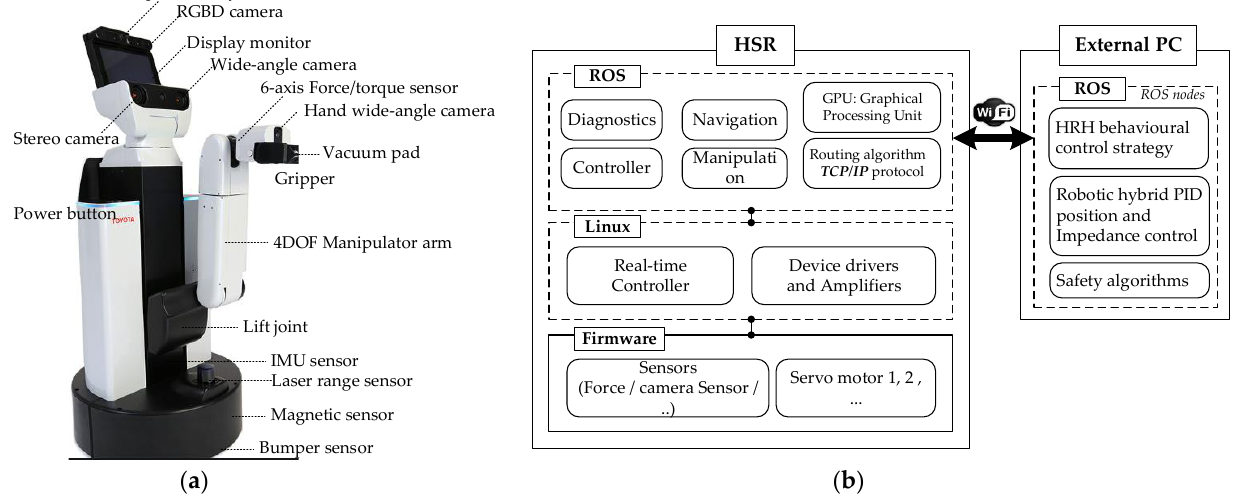
Figure 1. ( a ) The hardware equipment of the HRS and ( b ) HRS software architecture (connecting to an external PC).